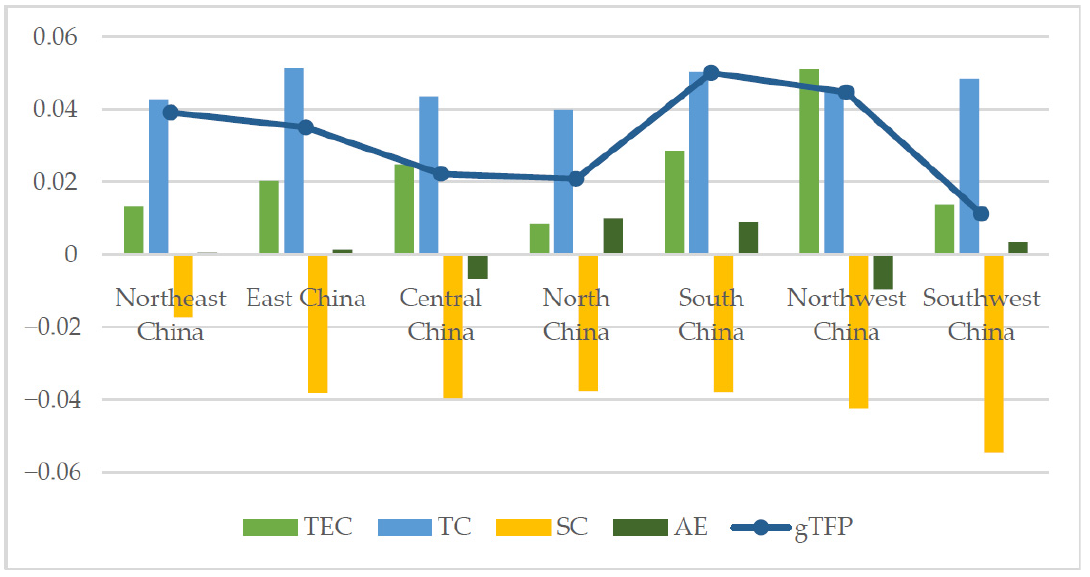
Figure 5. Decomposition diagram of TFP of listed companies by region.